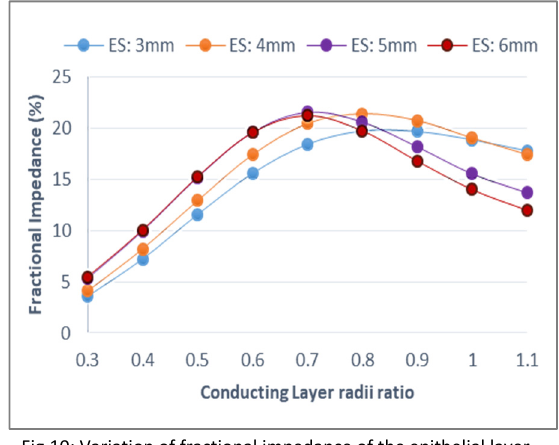
Fig.10: Variation of fractional impedance of the epithelial layer with conical bolus radii ratio for different electrode separations (edge to edge) while the bolus height was constant at 1.2